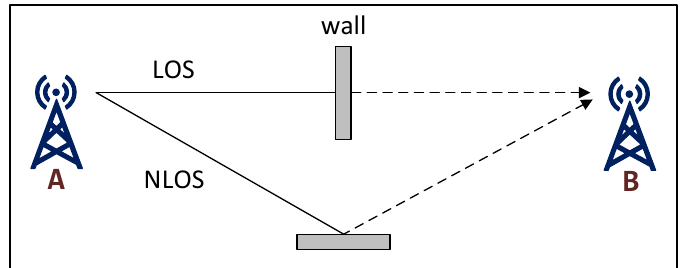
Figure 2. Line-of-sight (LoS) vs. non-line-of-sight (NLoS) signal